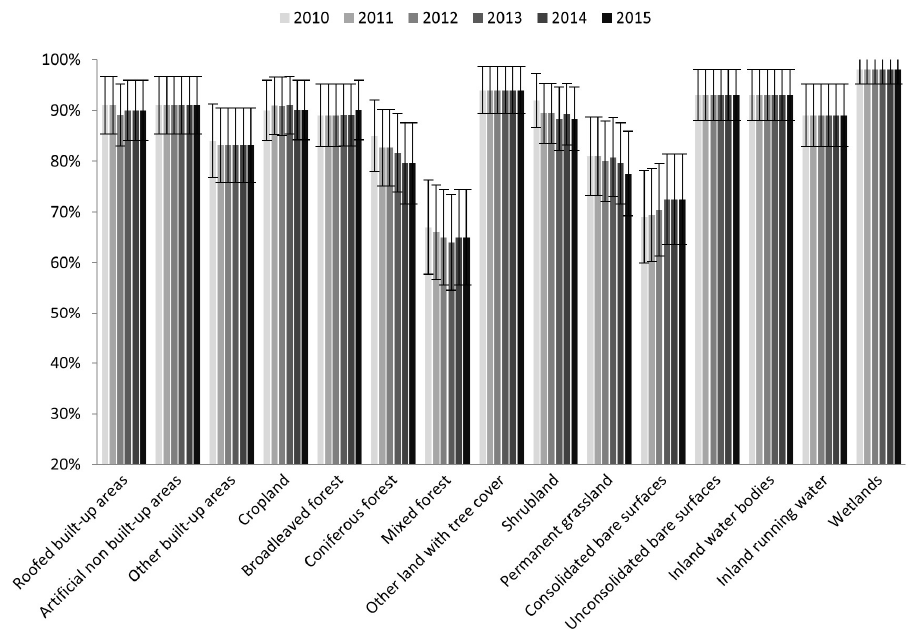
Figure 5. Estimated user’s accuracy of the maps with a 95% confidence interval.